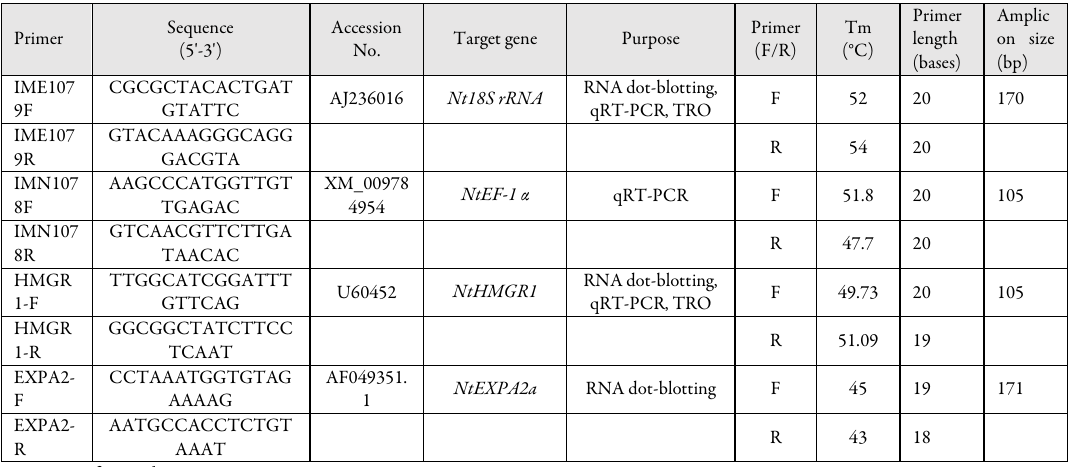
Table 1. List of primers used in this